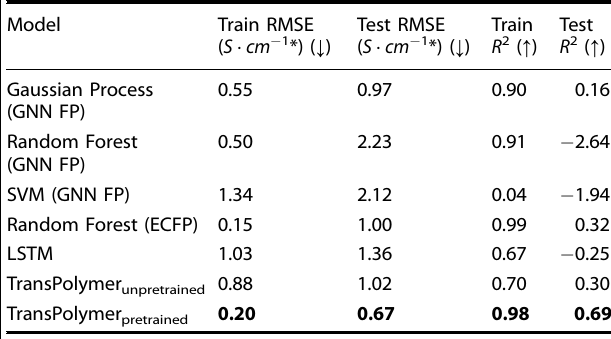
Table 2. Performance of TransPolymer and baseline models on